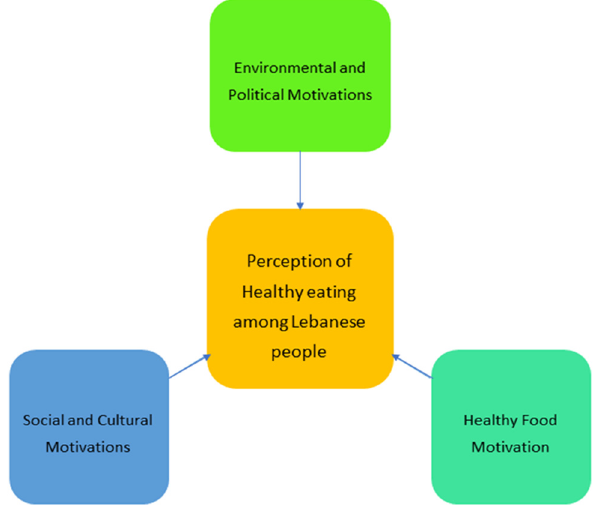
Figure 3: A research model for research question